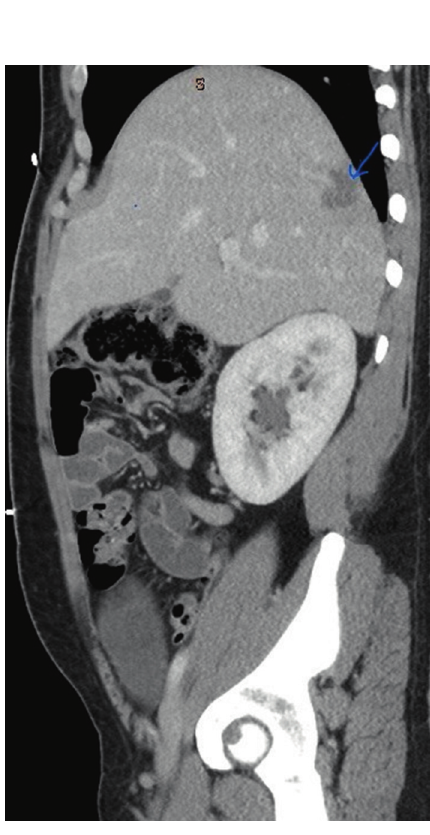
Figure 2: Sagittal view of the abdomen revealing the liver abscess.